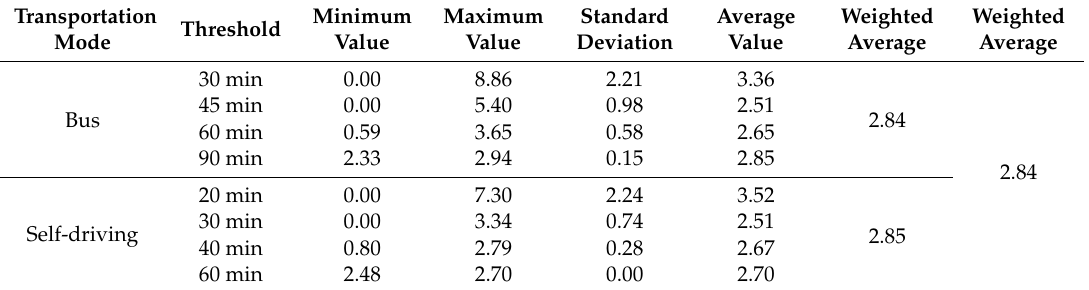
Table 2. Sensitivity of accessibility when changing the transportation mode and